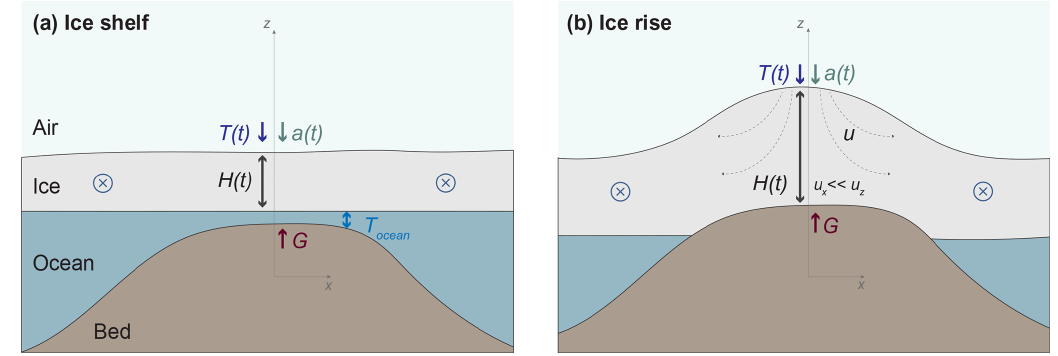
Figure 2. Geometry of the ice shelf and ice rise heat flow model. The simple one-dimensional vertical model is implemented along a station- ary crest of hypothetical ice rise ( z axis on the figure) and bedrock beneath it. T (t) and a(t) indicate surface temperature and accumulation forcings, respectively. G is geothermal heat flux, and u is ice-flow velocity (along the crest of ice rise, horizontal flow velocity u x is negligibly small comparable to its vertical component u z or w ).